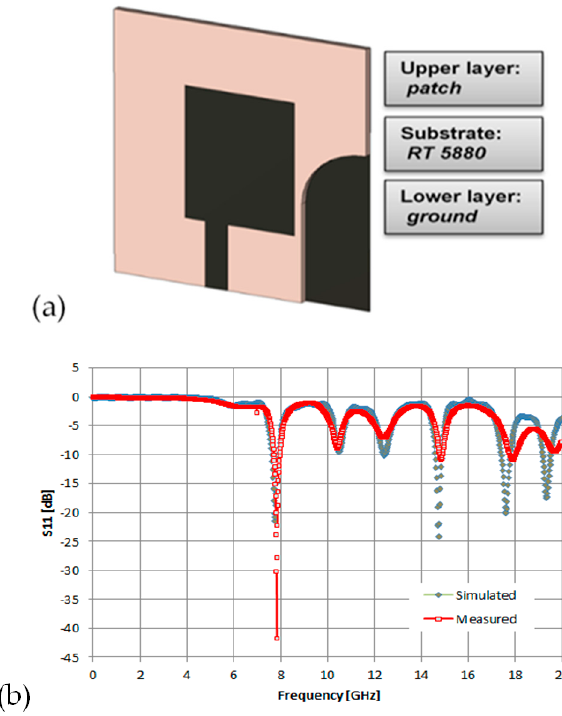
Figure 1. ( a ) Geometry of conventional microstrip antenna; ( b ) simulated and measured S11 of the conventional microstrip antenna.